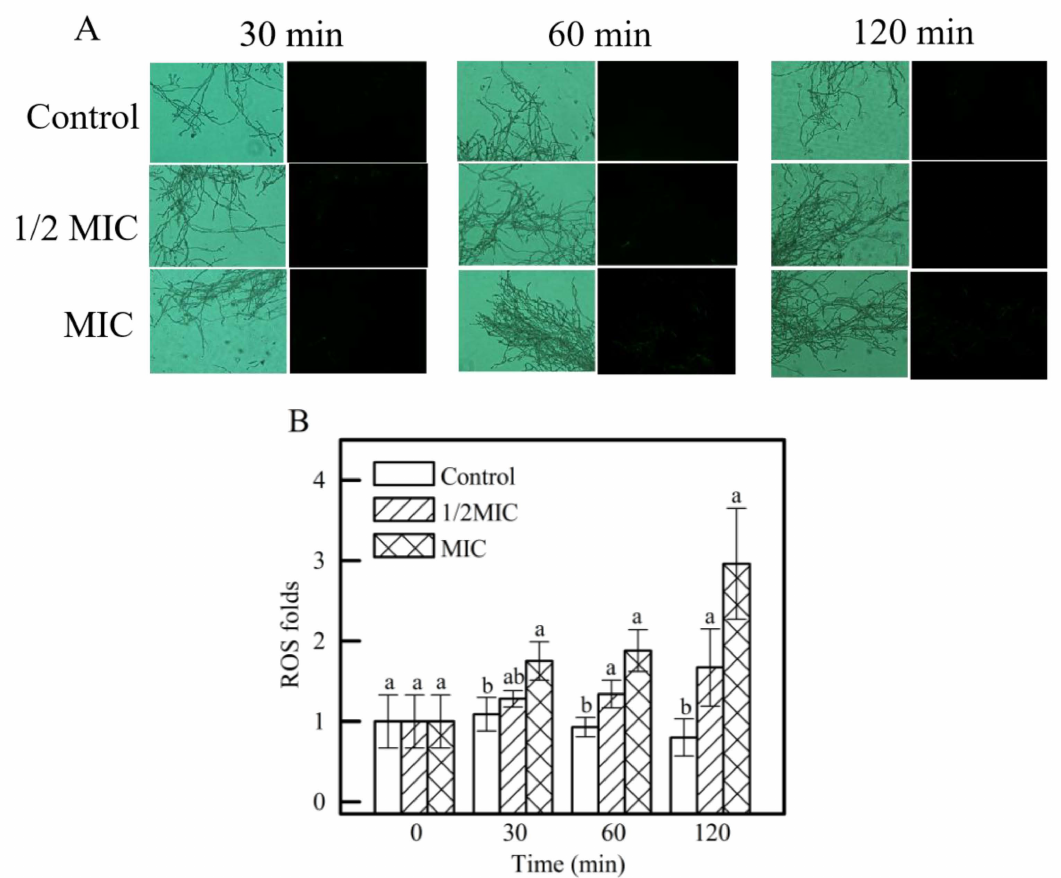
Figure 8. Effect of γ -CDCL on the ROS accumulation of P. digitatum mycelia. ( A ) Fluorescence images of different treatment concentrations (Control; 1/2 × MIC; 1 × MIC) for 30, 60, 120 min; ( B ) the fluorescence fold changes of the DCFH-DA staining. Data are expressed as the means ± standard deviation of pooled data ( n = 3, p < 0.05). γ -CDCL, cinnamaldehyde/ γ -cyclodextrin inclusion complex; ROS, reactive oxygen species; MIC, minimum inhibitory concentration; DCFH-DA, 2 (cid:48) − 7 (cid:48) dichlorofluorescein diacetate. Dissimilar lowercase letters in the histogram express the statistical significance among different treatments at the same